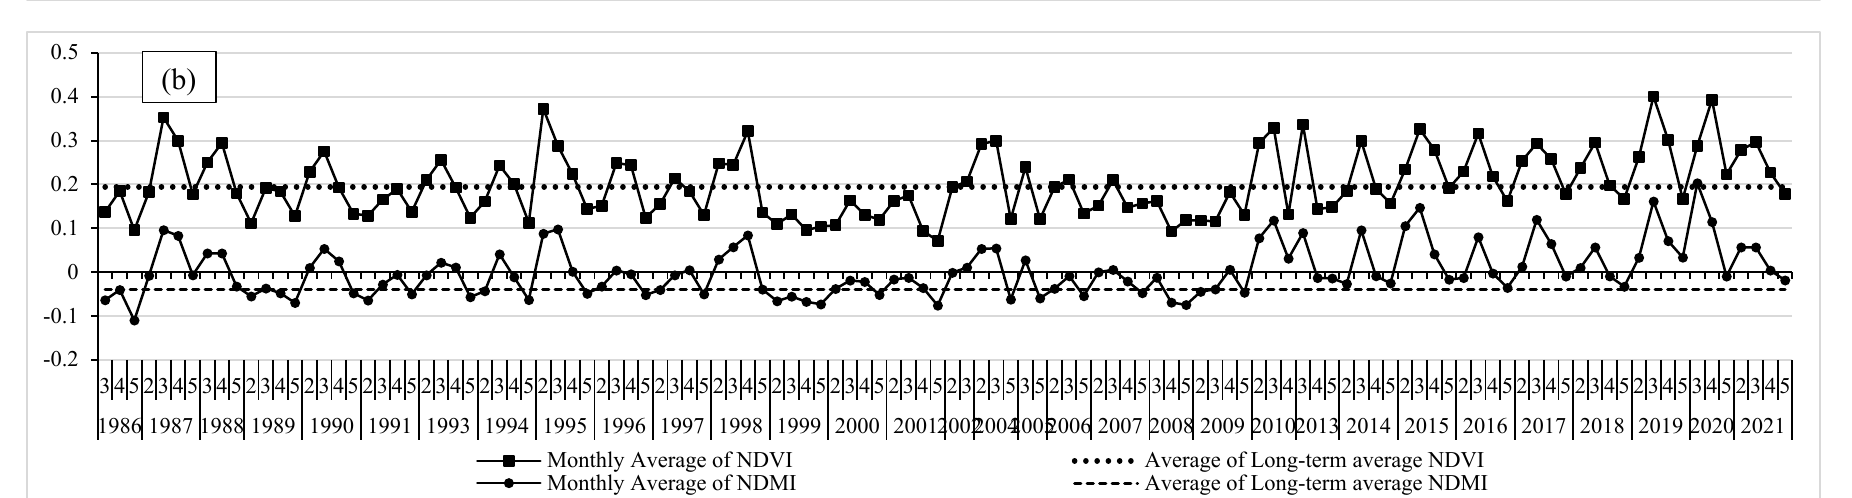
Figure 5. Spatiotemporal phenological profiles of the monthly average NDVI and NDMI values in ( a ) Jordanian and ( b ) Syrian parts of YRB during all growing seasons between 1986 and 2021.